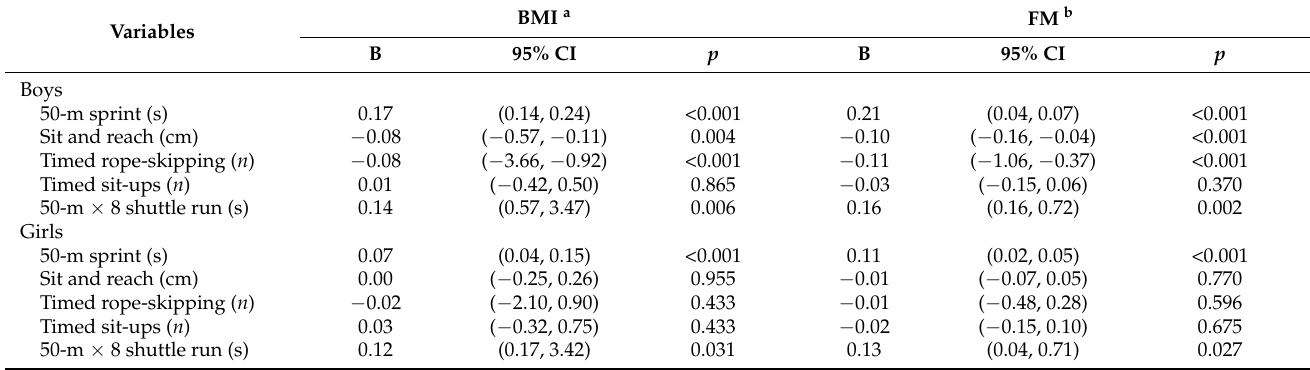
Table 3. Results of the linear regression analyses of BMI, FM, and health-related physical fitness.